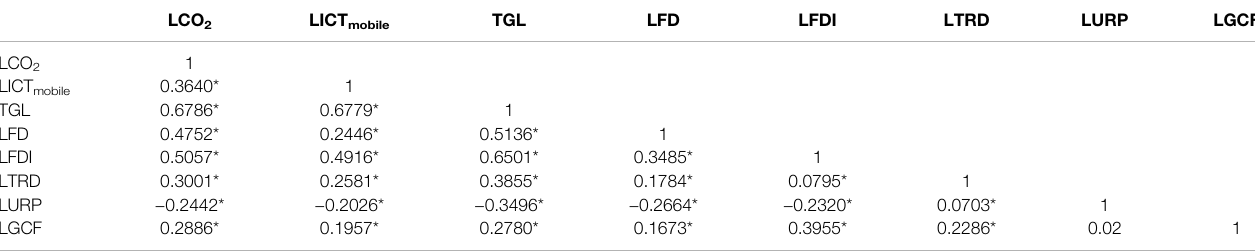
TABLE 4 | Correlation matrix.